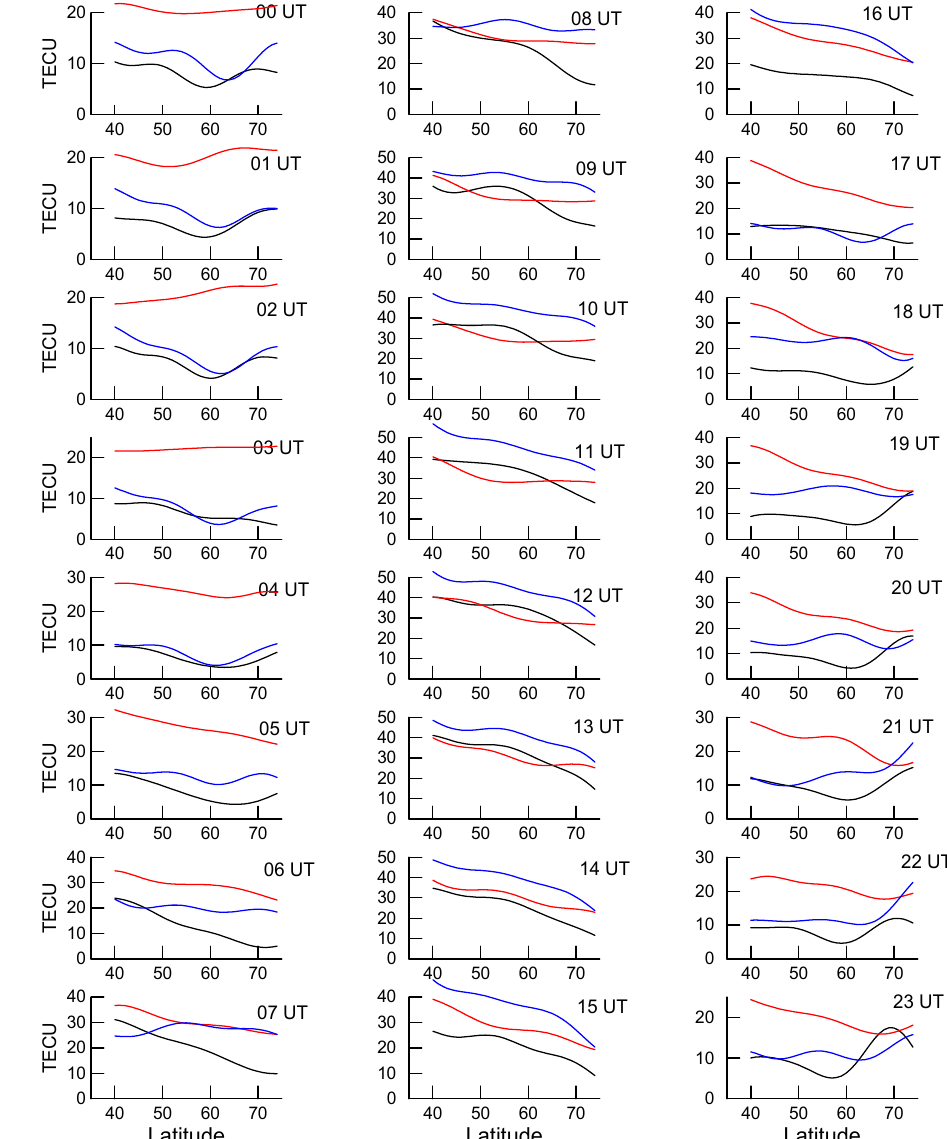
Fig. 2. Latitudinal TEC profiles over Europe at longitude 20 ◦ E. Black line – 5 November 1999, P K p = 9, red line – 18 July 2000, P K P K Fig.2 Latitudinal TEC profiles over Europe at longitude 20o E. Black line – 5 November 1999, ∑ Kp = 9, r ed p = 12, blue line – 15 March 2001, p = line – 18 July 2000, ∑ Kp = 12, blue line – 15 March 2001, ∑ Kp = 4.